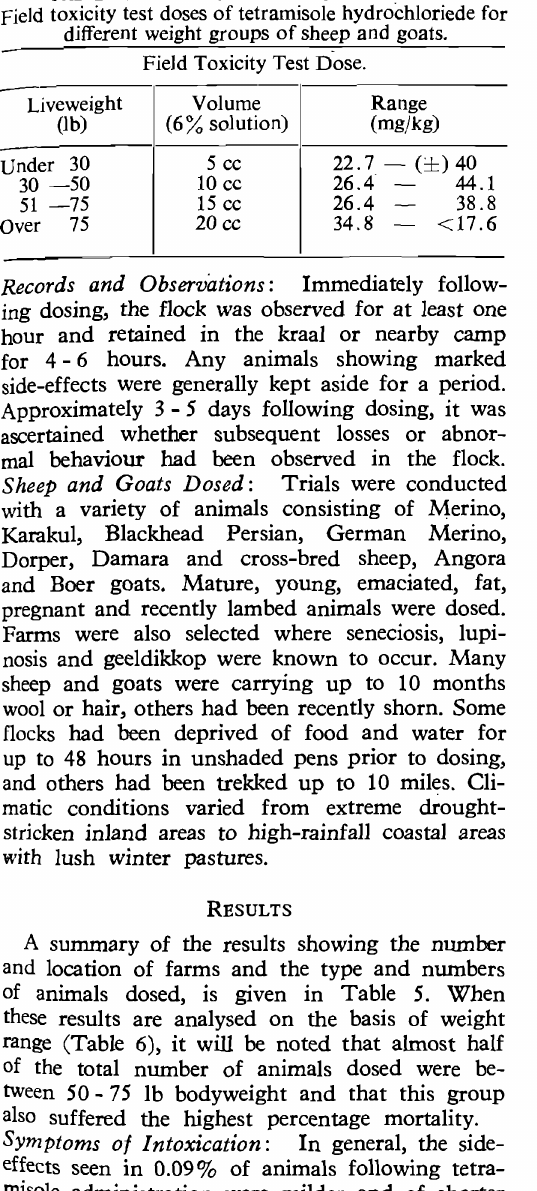
TABLE 4.-FIELD TOXICITY STUDIES. Field toxicity test doses of tetramisole hydrochloriede for different weight groups of sheep and